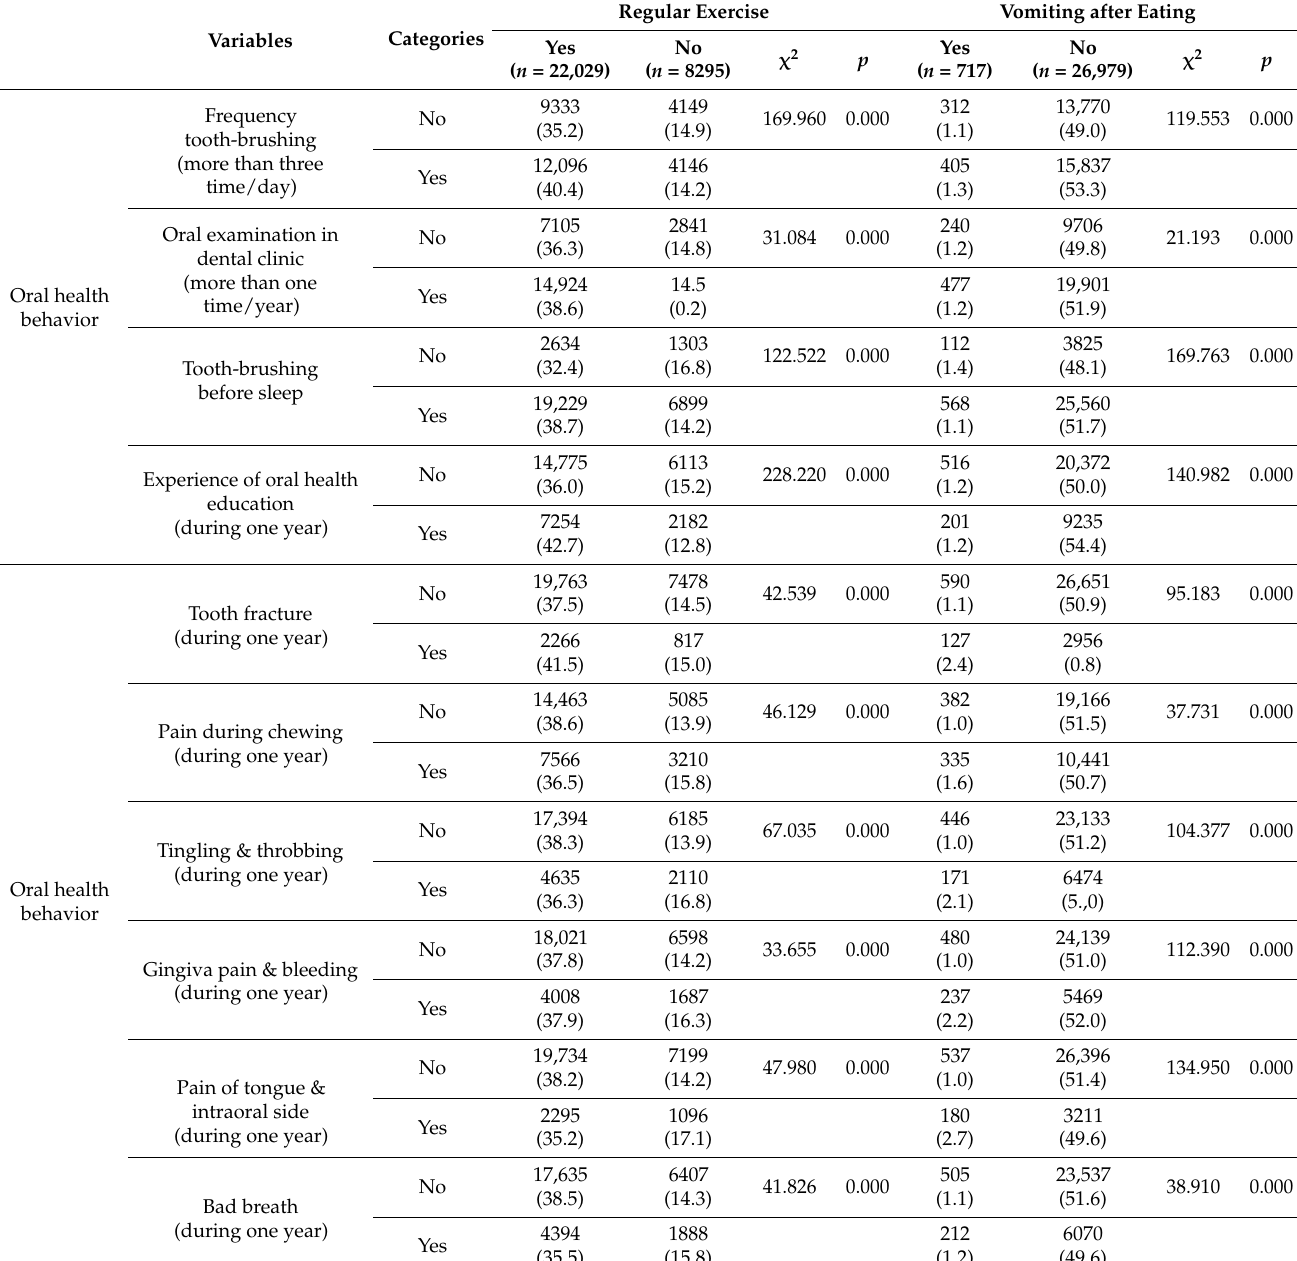
Table 4. Oral health behavior and oral disease symptoms according to weight loss